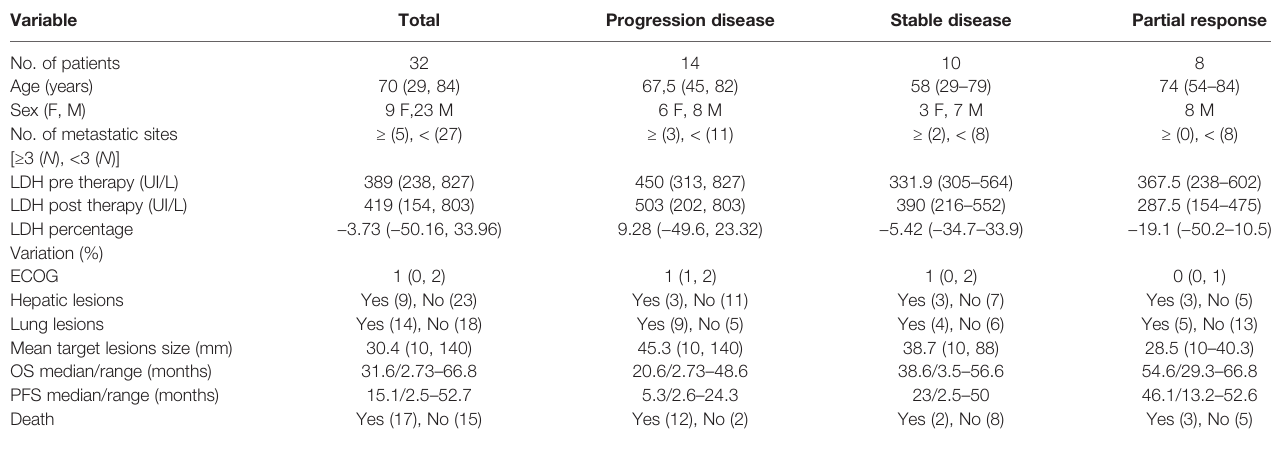
TABLE 1 | Main demographic characteristics and relevant clinical data are reported in the table. Variable